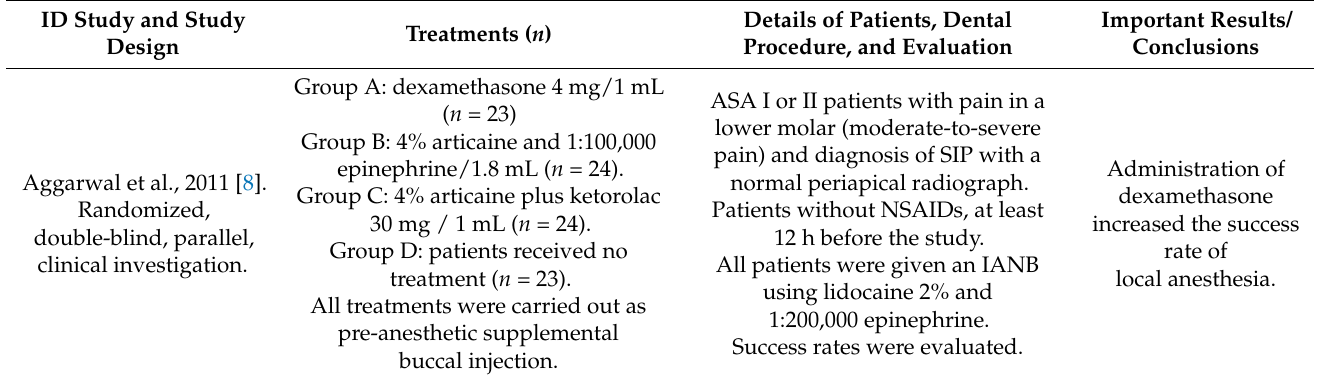
Figure 2. Risk-of-bias assessment.